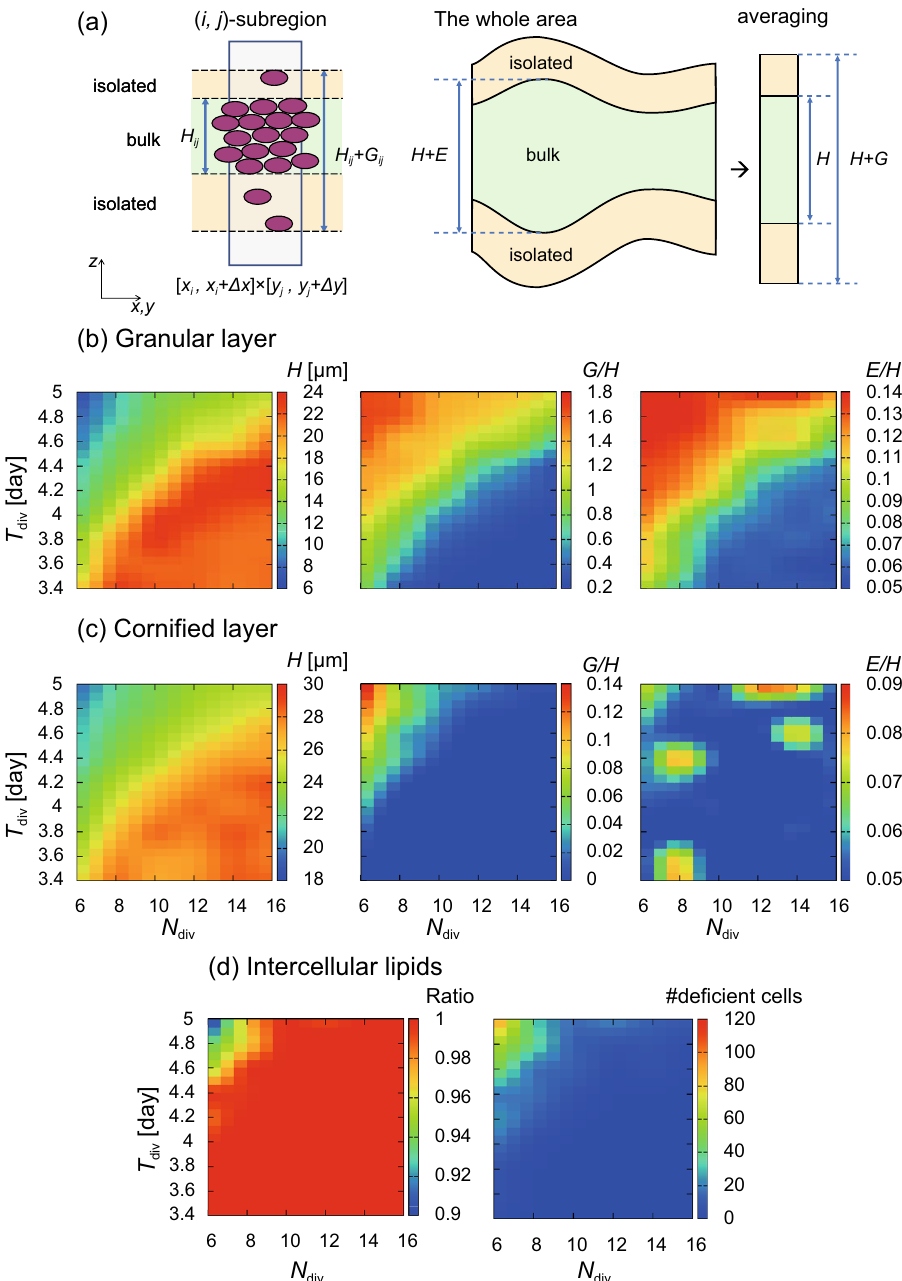
Figure 2. Evaluation of the epidermal structures and the lipid production as functions of N div (maximum number of cell divisions) and T div (cell division period). ( a ) Schematic illustration of the definition of the mean thickness H , the dispersion G , and the spatial variation E . ( b ) Thickness H , relative dispersion G / H normalized by thickness, and relative spatial variation E / H normalized by thickness for the granular layer. ( c ) H , G / H , and E / H for the cornified layer. ( d ) Ratio of the lipid content released from cornified cells to the maximum lipid production (left) and the number of lipid-deficient cornified cells with inadequate lipid production (less than 50% of the maximum) (right). All values in ( b )–( d ) are time-averaged over 280 days (approximately 10 turnovers). See Methods for precise definitions of the evaluation